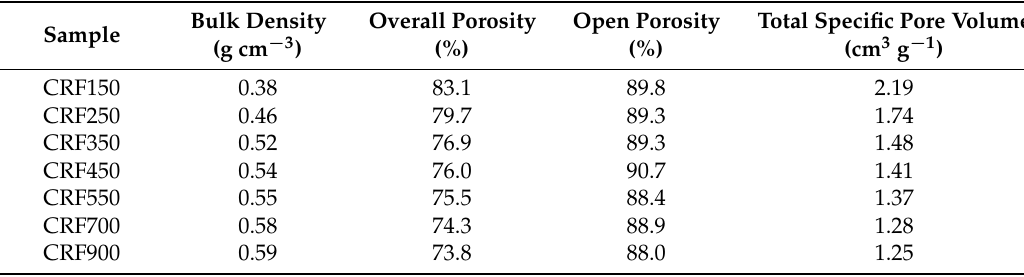
Table 2. Density and porosity of cellular carbon